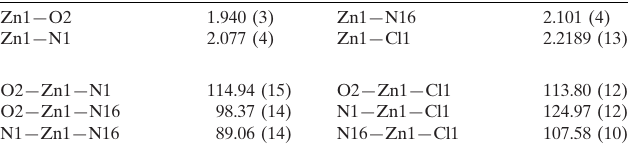
Selected geometric parameters (A˚ , (cid:3)